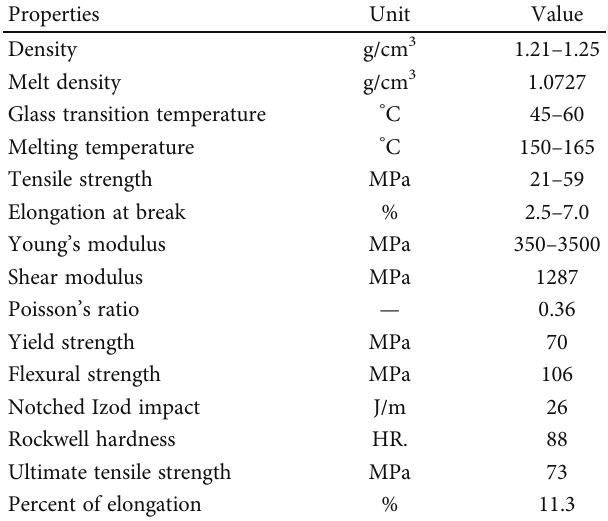
Table 1: Physical and mechanical properties of polylactic acid [15].